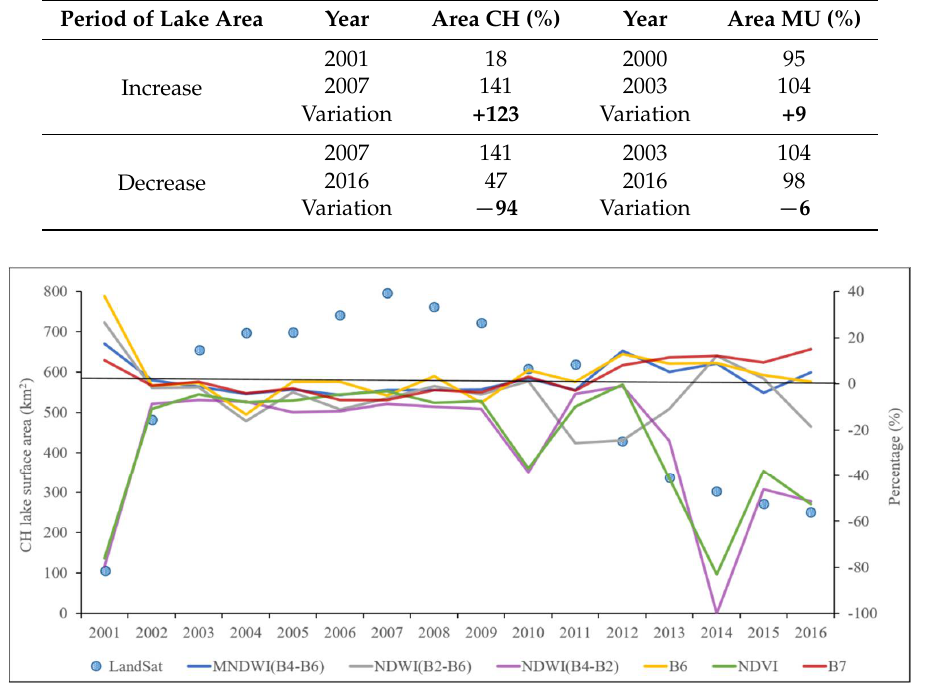
Figure 2. Colhué Huapí lakes (CH) area calculated with Landsat images (left axis). Differences (in percentage) between lake areas obtained with the MODIS (indexes and bands) and Landsat images (right axis). When lake area reached it largest extension the differences between the areas calculated with the MODIS and Landsat images is lower (e.g., 2007). The opposite occurred when lake area reached its lowest extension (e.g., 2001).